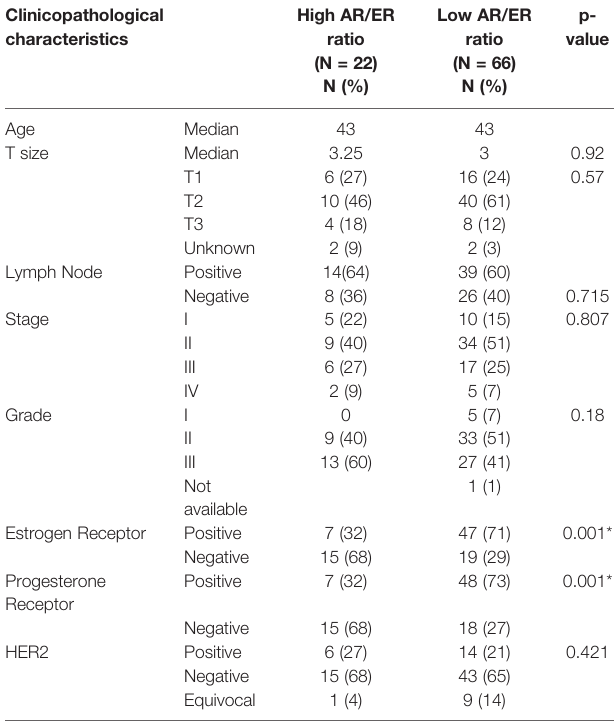
TABLE 2 | Comparison of clinical variables between high and low AR/ER ratio groups in our cohort in the patients ≤ 50 years. Clinicopathological characteristics